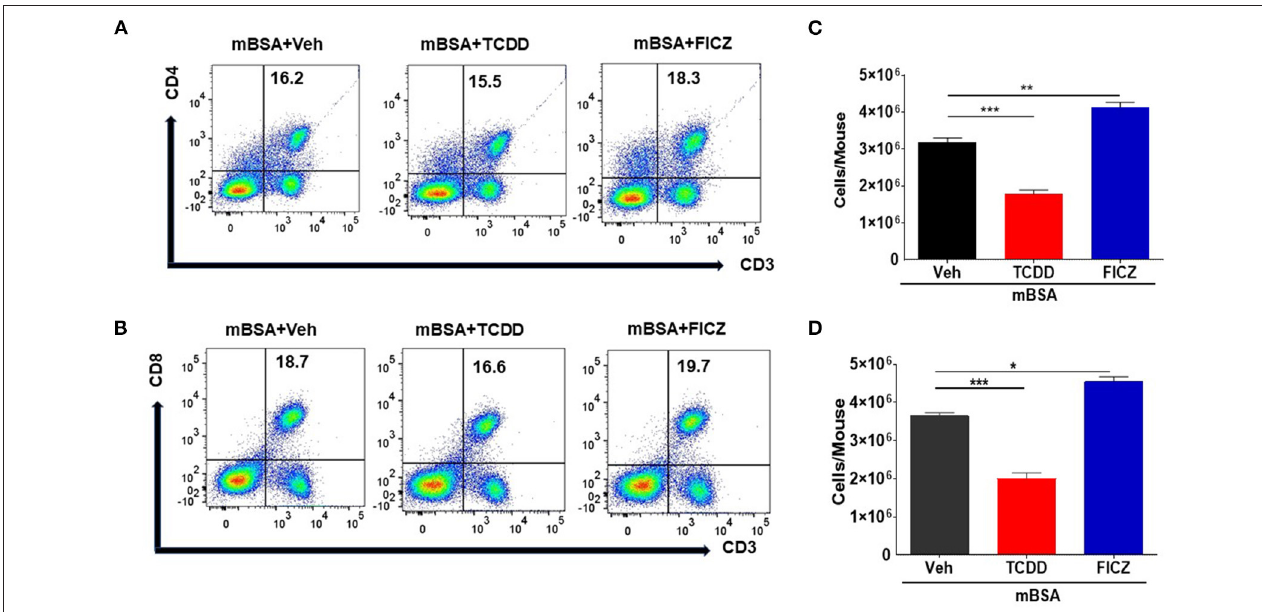
FIGURE 2 | TCDD treatment reduces T cell infiltration in DLNs in mBSA-induced DTH. DTH was induced as described in Figure 1 legend and DLNs were analyzed for T cells. (A) Representative plots from FlowJo software analysis of flow cytometry data showing cells double-stained for CD3 and CD4. (B) Shows absolute cell numbers of CD3 + CD4 + T cells in DLNs of various treatment groups. These numbers were calculated based on the absolute number of cells in DLN multiplied by the percentage values of CD3 + CD4 + cells obtained by flow cytometry, divided by 100. (C) Representative plots from FlowJo software analysis of flow cytometry data showing cells double-stained for CD3 and CD8. (D) Absolute number of CD3 + CD8 + cells. The statistically significant differences between the groups were calculated using one-way ANOVA. Vertical bars represent Mean ± SEM and significant differences between groups were indicated by asterisks (* p < 0.05, ** p < 0.01, *** p < 0.001).